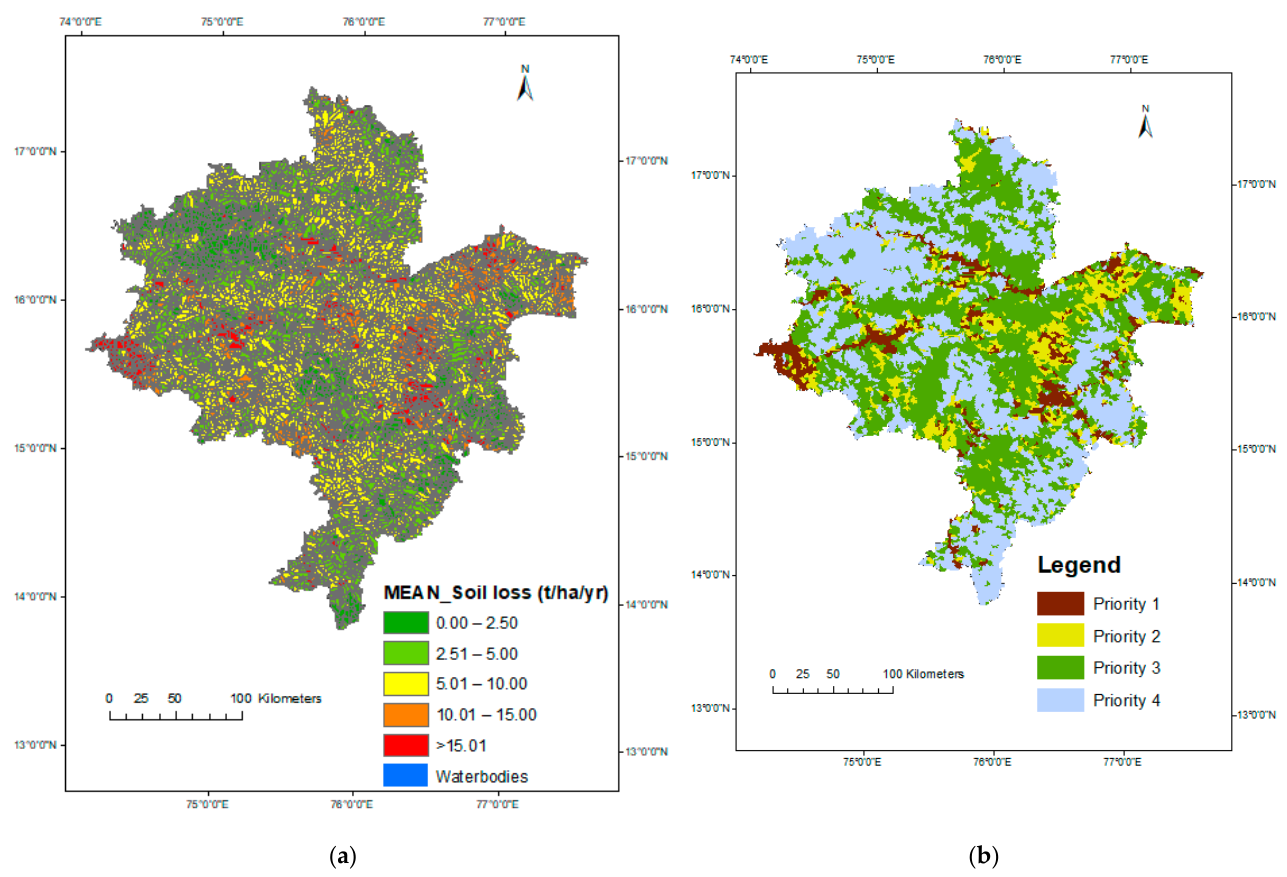
Figure 7. ( a ). Catchment-wise soil loss in the study area. ( b ). Prioritization for implementing soil erosion control measures.